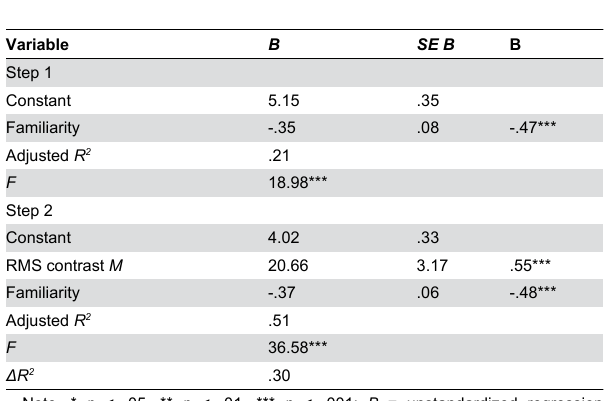
figure-ground composition and half a complex scene. The paintings were all in landscape format and saved in the same size (1024 x 768 pixels) and resolution (72dpi) in JPEG format (maximum quality) as the IAPS pictures used in Experiment